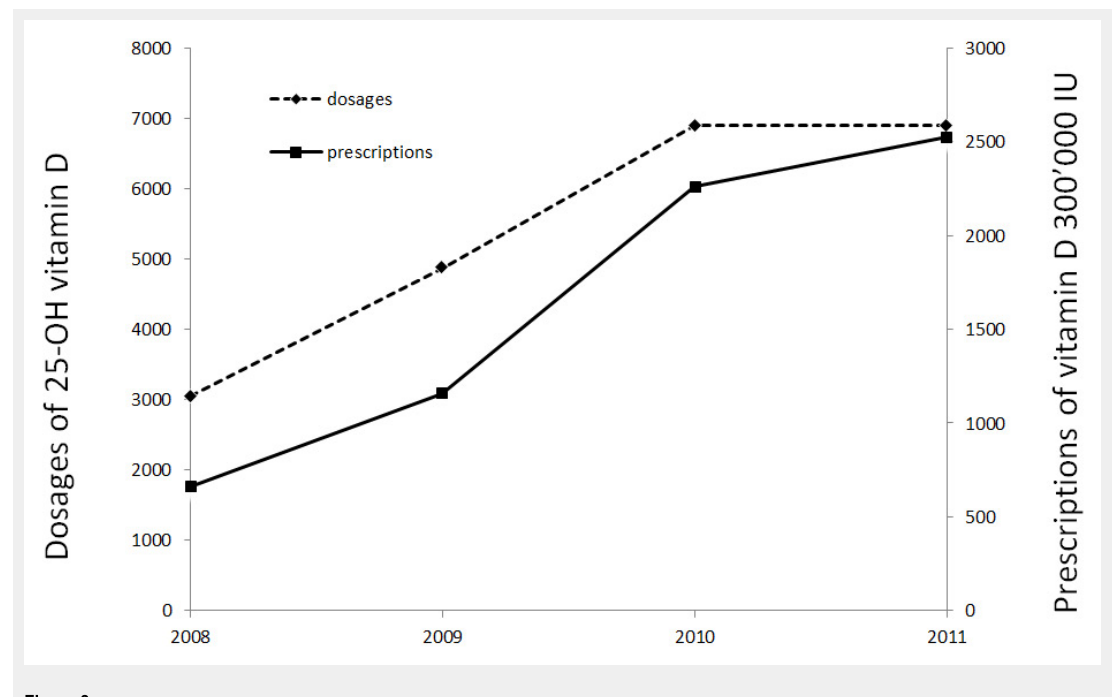
Figure 3 Evolution of vitamin D dosages and prescriptions between 2008 and 2011 in Lausanne University